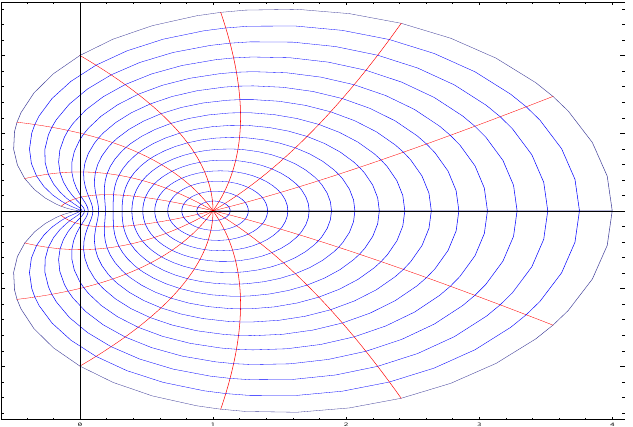
(cid:0) π (cid:1) , π , ψ ( z ) if ψ ( z ) = ( 1 + z ) 2 2 2